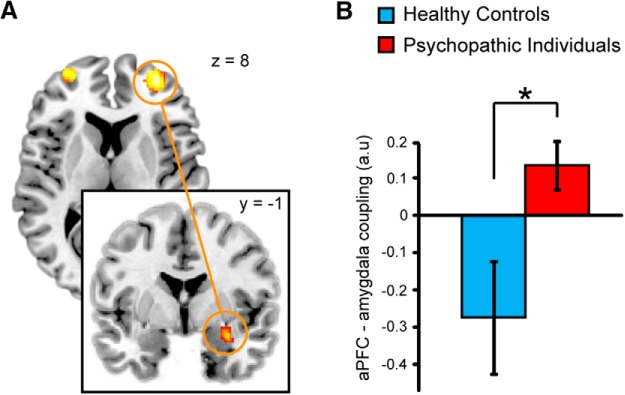
Group difference on congruency-related aPFC–amygdala connectivity. A, Brain images illustrating the congruency-related modulation of connectivity between the right aPFC (yellow circle, axial slice) and the right amygdala (coronal slice) for the congruency contrast. The activations are presented at p < 0.05, uncorrected for visualization purposes. B, Bar graph visualizing the strength of the congruency-specific change (±SEM) in aPFC–amygdala connectivity for the healthy control subjects and psychopathic offenders. There is a significant negative aPFC–amygdala coupling in the healthy control subjects, which is not present in the psychopathic offenders.